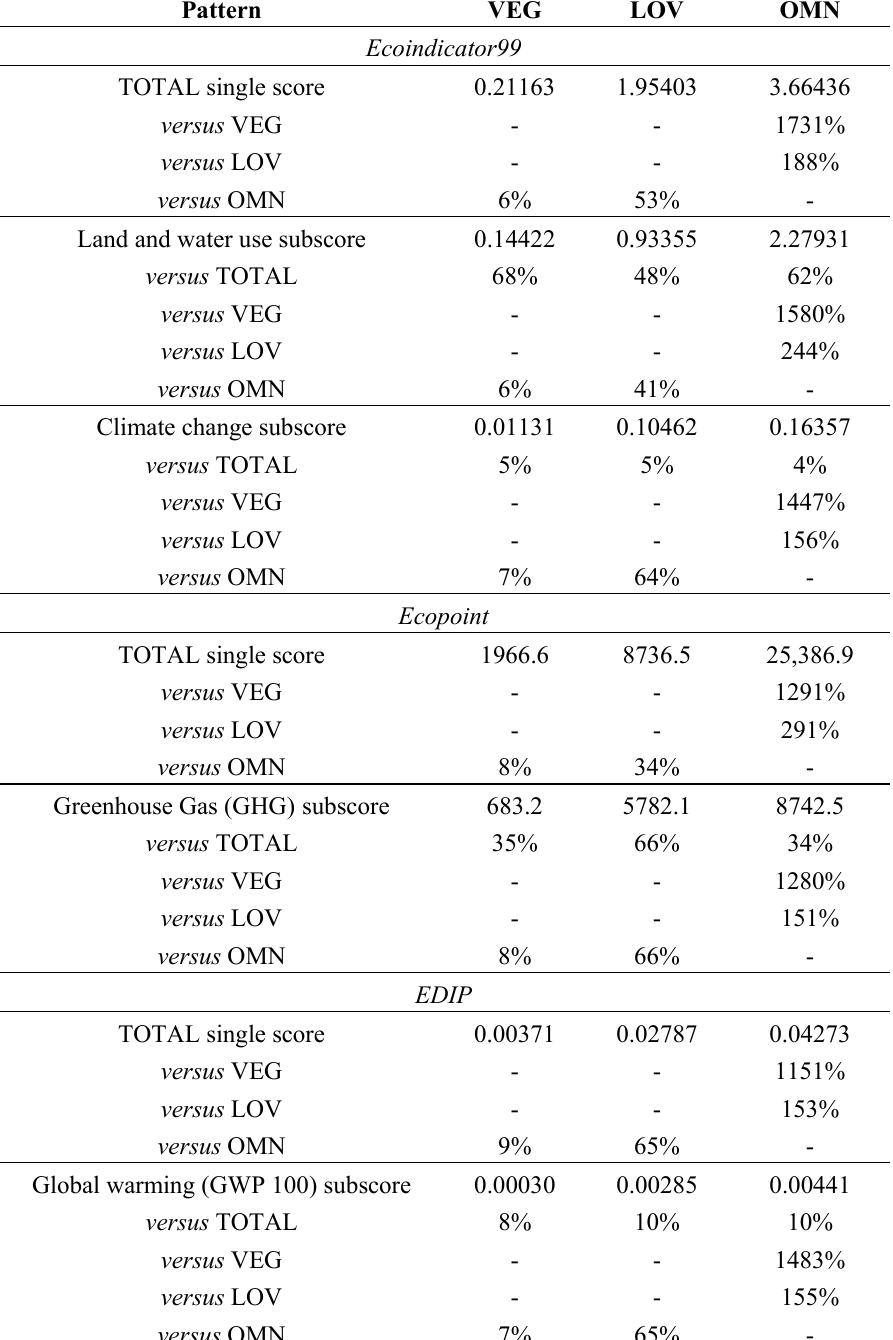
Table 4. Delta study: land & water use and GHG subscores (indicated as single score, Pt per week) of the 19% component in which the three 2400 kcal patterns differ (delta), according to each